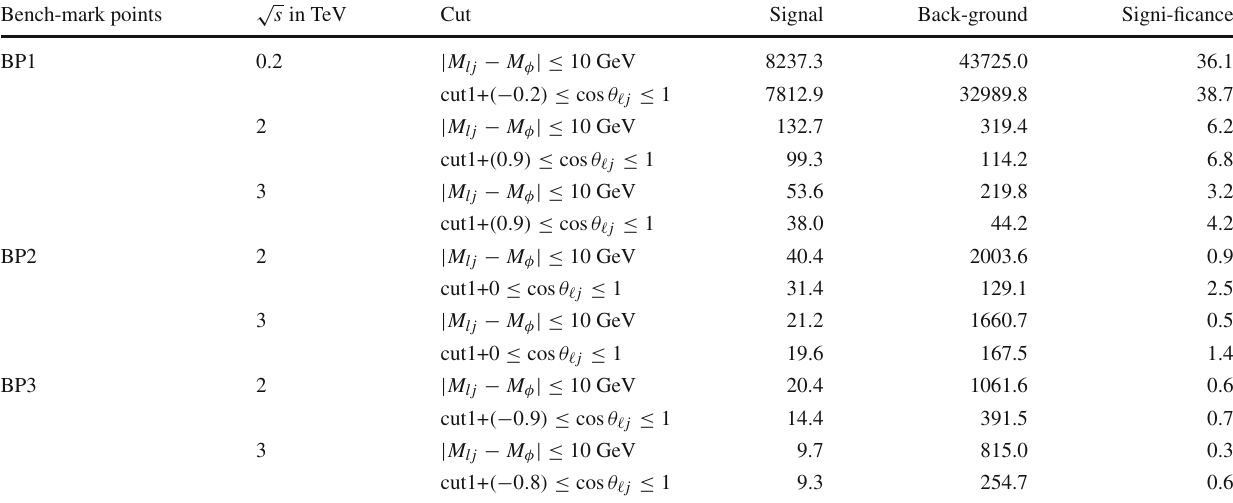
/ 3 ) c with luminosity 100 fb − 1 at e – γ collider 3